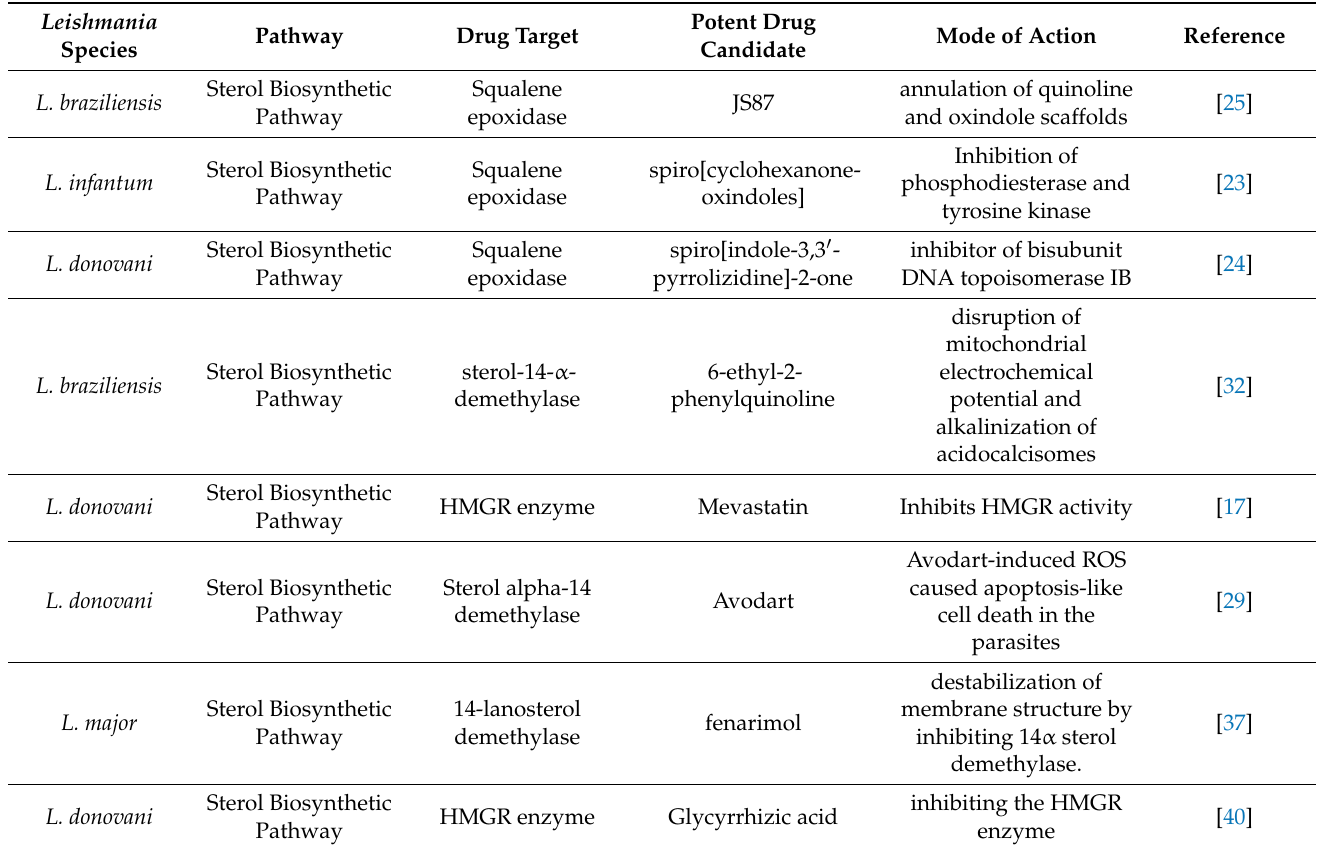
Table 1. Potential drug targets, repurposed drugs, and their mode of action to limit